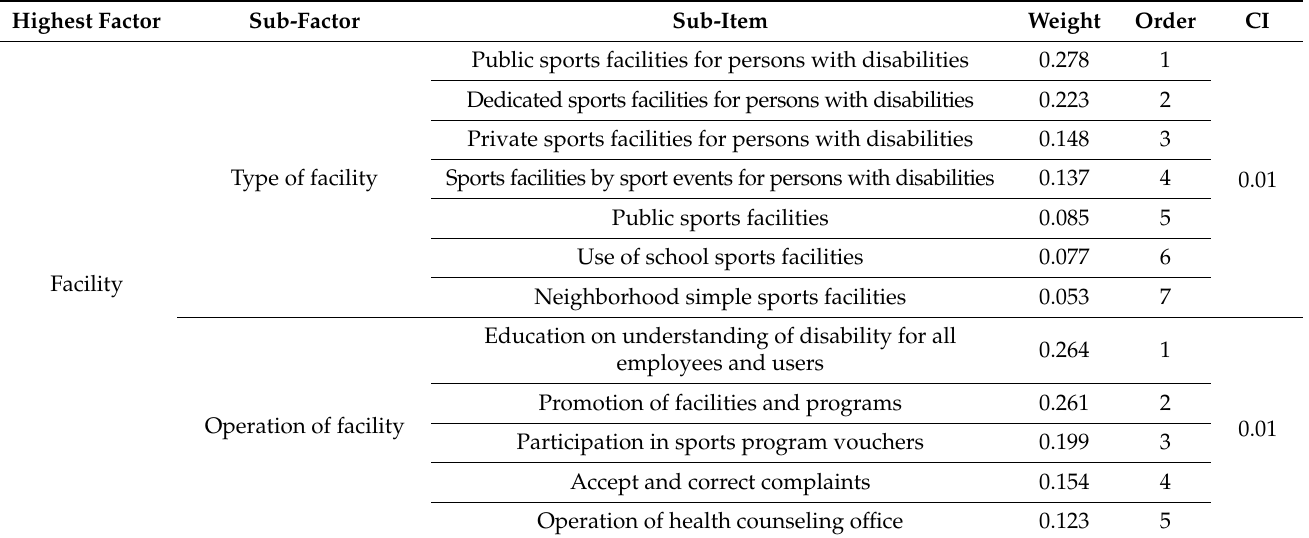
Table 11. Results of the relative importance of H4 by the facility in H3.